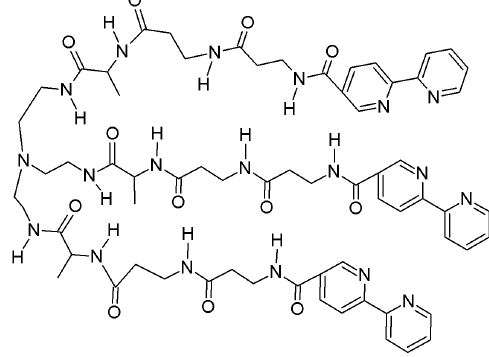
Figure 19. A triple-stranded ligand can switchably bind Fe 2+ and Fe 3+ at two different sites, respectively [85].